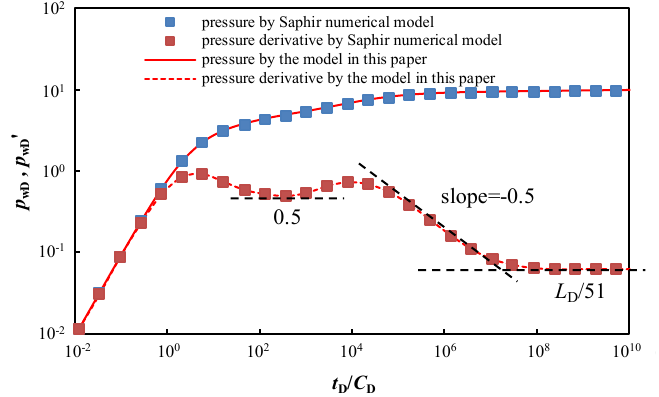
Figure 2. Comparison between the numerical solution and the analytical solution ( n = 50).